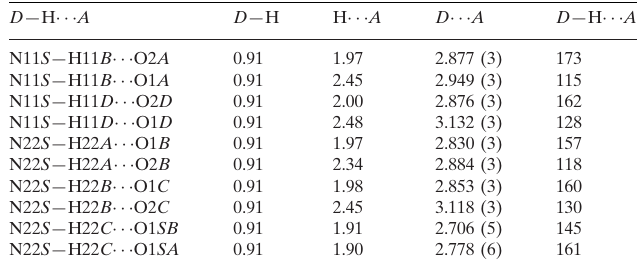
Data collection: CrysAlis CCD (Oxford Diffraction, 2007); cell refinement: CrysAlis RED (Oxford Diffraction, 2007); data reduc- tion: CrysAlis RED ; program(s) used to solve structure: SHELXS97 (Sheldrick, 2008); program(s) used to refine structure: SHELXL97 (Sheldrick, 2008); molecular graphics: SHELXTL (Sheldrick, 2008); software used to prepare material for publication: SHELXTL